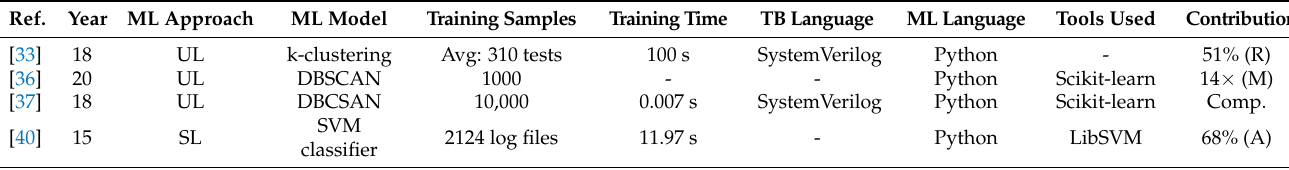
Table 3. Comparative summary of state of the art ML contributions in Section